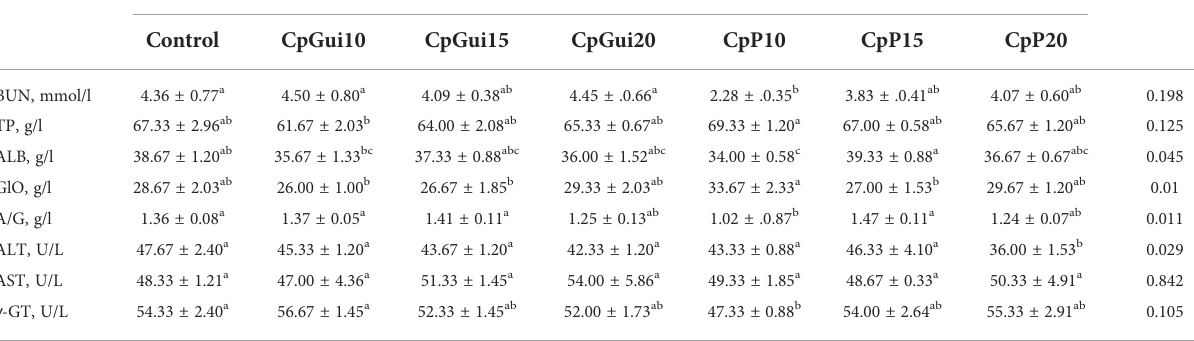
TABLE 4 Effect of different feed composition diets on blood pro fi les in fattening pigs.